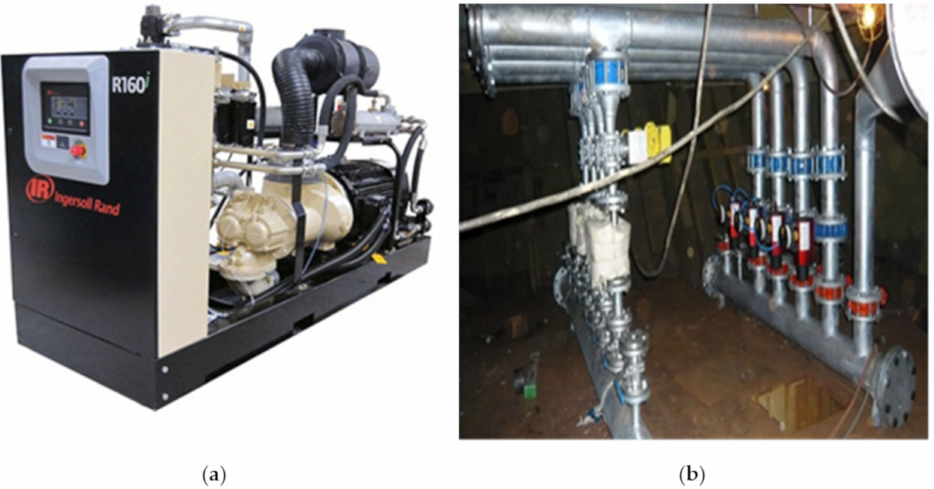
Figure 11. ( a ) Ingersoll Rand Suitable compressor; ( b ) Piping